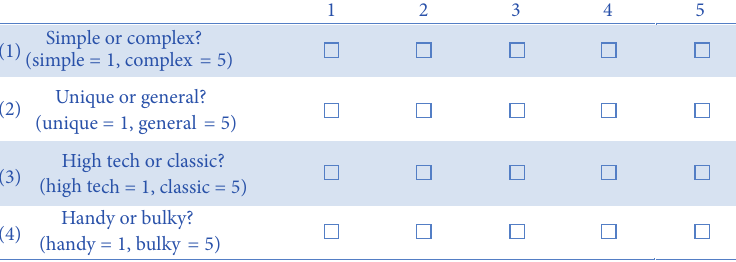
Figure 6: The questionnaire format for each mobile